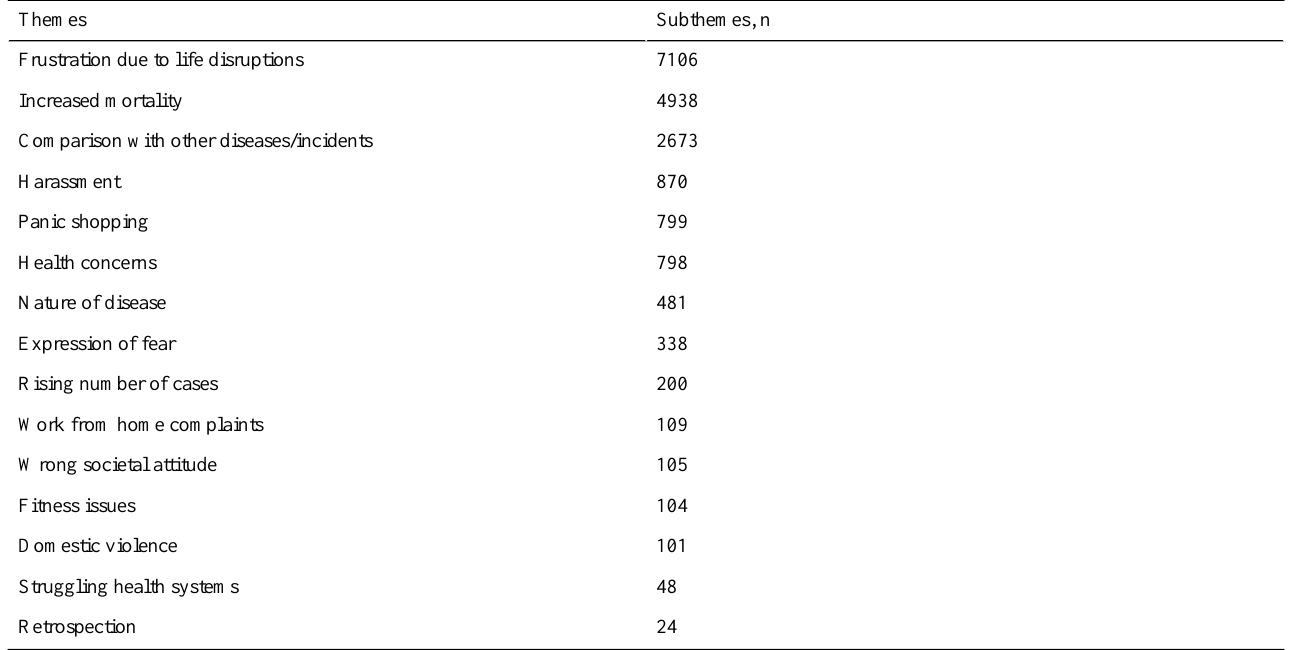
Table 5. Negative themes and the corresponding number of